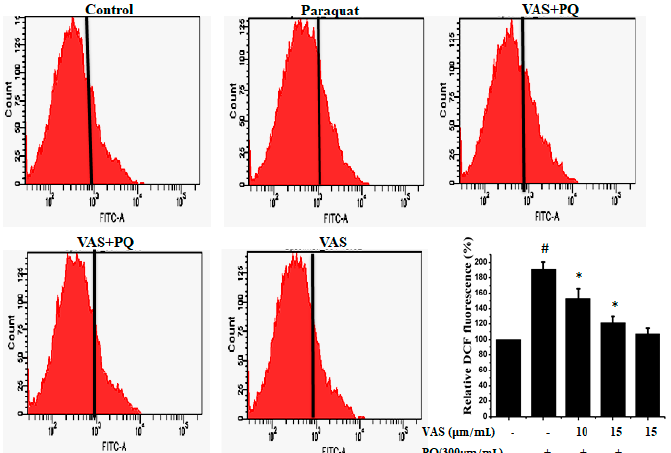
Figure 2. Vasicinone attenuated the paraquat-induced accumulation of reactive oxygen species (ROS) in SH-SY5Y cells. The results are expressed as the % of dichlorofluorescein (DCF) fluorescence. # p < 0.01, significantly different from control cells; * p < 0.01, compared with paraquat-treated cells. VAS: Vasicinone; VAS + PQ: Vasicinone + Paraquat.